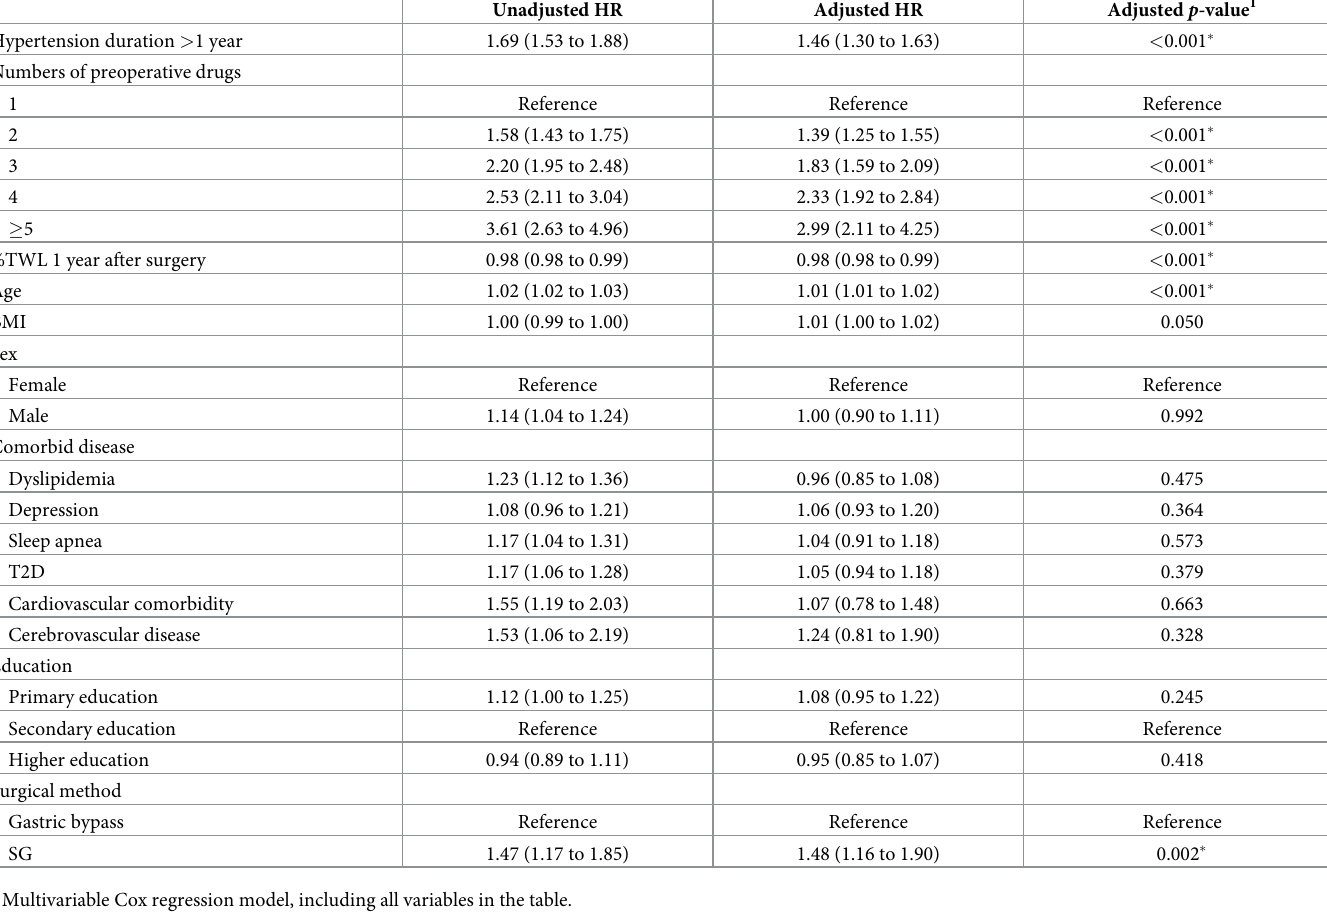
Table 3. Factors associated with risk for relapse of